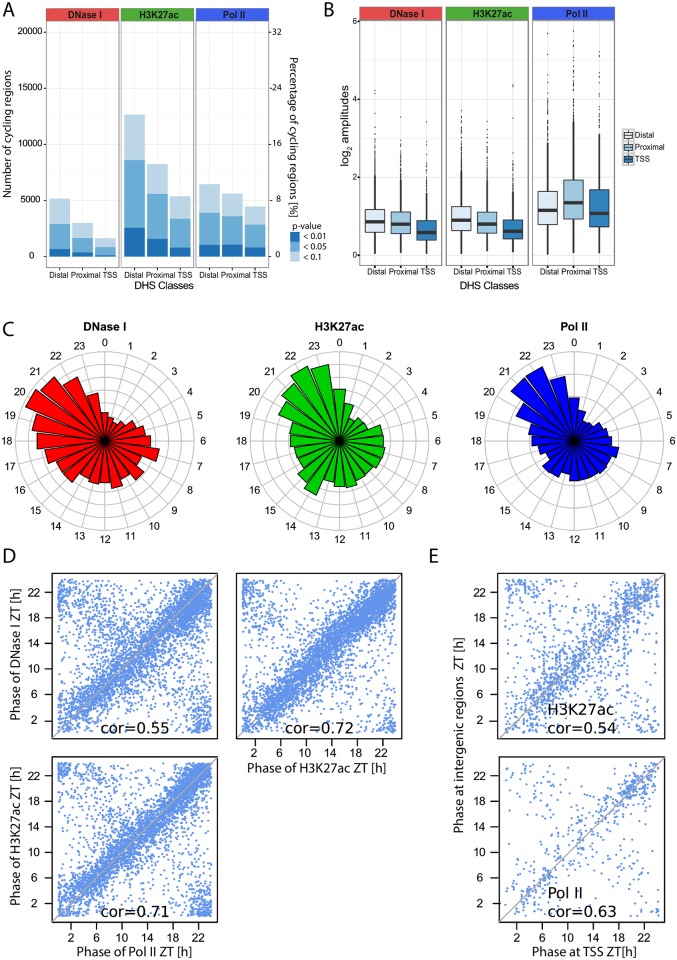
Genome-wide rhythms in DNase I signals are synchronous with RNA Polymerase II (Pol II) transcription and histone acetylation.A. Number of DNase I hypersensitive sites (DHSs) with statistically significant cycling DNase I signals (left), H3K27ac signals (middle), or Pol II signals (right) at three different thresholds (p < 0.1, p < 0.05 and p < 0.01, harmonic regression), partitioned according to their genomic location: TSS (1 kb), proximal (1–10 kb from TSS), or distal (>10 kb from TSS). B. Comparison of log2 amplitudes for DHSs in each class (TSS, proximal, and distal) and in each signal (Pol II, H3K27ac, and DNase I). We selected 4,606 sites (FDR < 0.05, Fisher's combined test). Higher amplitudes were observed in distal and proximal regions compared to TSSs (p < 2.2*10−16, t test). In addition, Pol II loadings showed higher peak-to-trough ratios than the two other signals. C. Circular histograms representing the distributions of phases for each mark at DHSs selected as in B. D. Comparisons of peak times between DNase I, Pol II, and H3K27ac at DHSs (DHSs selected with p < 0.05, Fisher’s combined test), diagonals are indicated in gray. Values of circular correlations are indicated (p < 10−10, circular correlation). E. Relationships of peak times between DHSs in intergenic regions with their nearest TSS (pairs selected with FDR < 0.1, Fisher’s combined test). We found 1,611 and 630 significant pairs for H3K27ac and Pol II signals, respectively.